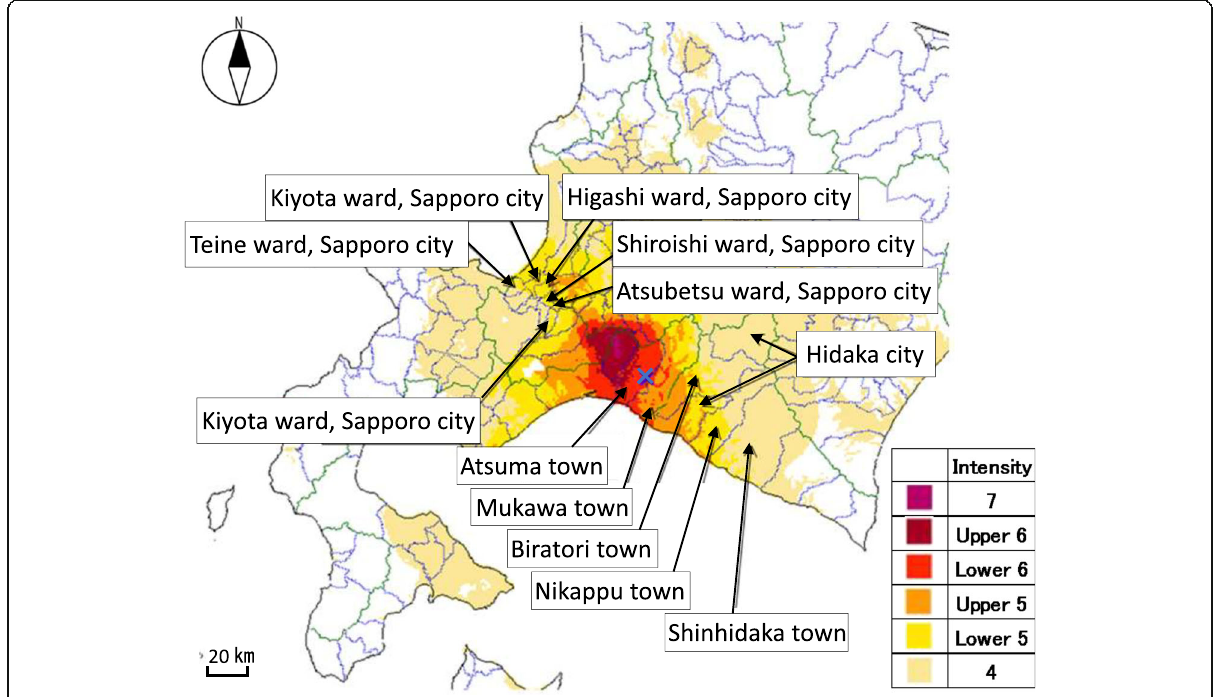
Fig. 1 Seismic intensity distribution of the 2018 Hokkaido Iburi-tobu Earthquake (Japan Meteorological Agency 2018)